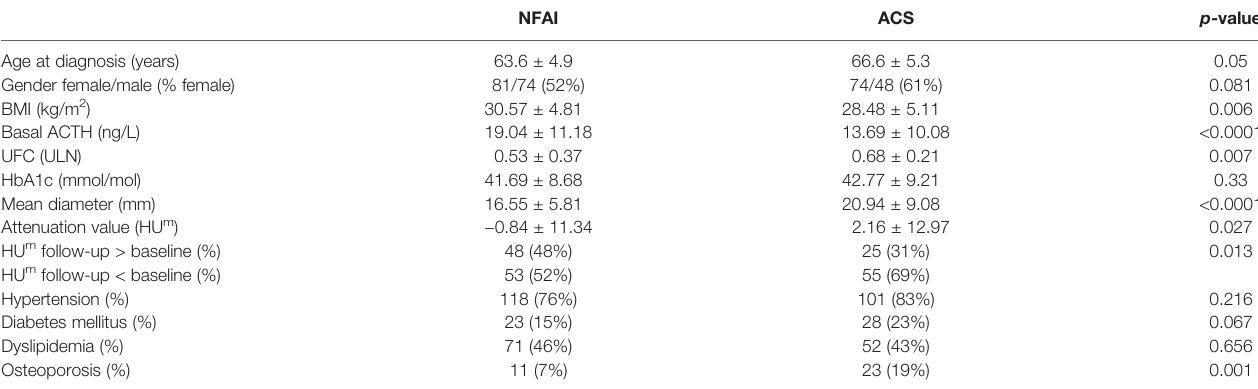
TABLE 1 | Clinical and radiological data, presented as mean and standard deviation, or percentage if